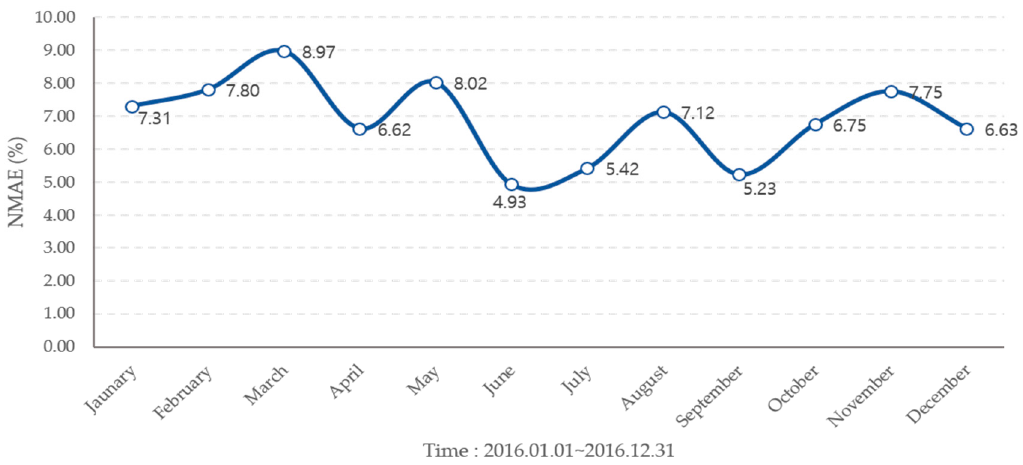
Figure 10. The NMAE for mean ensemble model forecasting result in 2016.